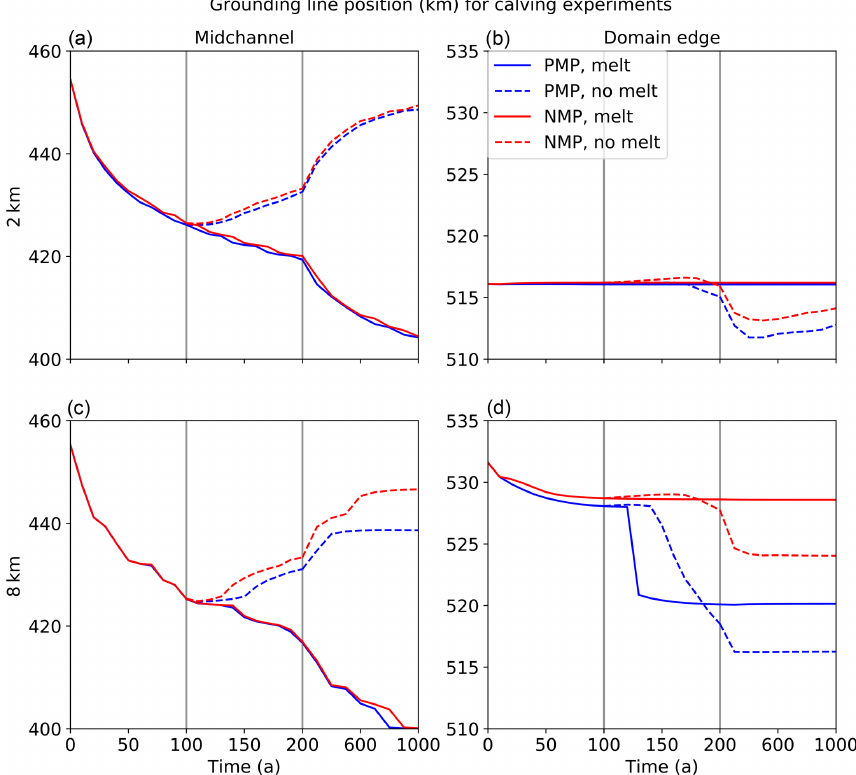
Figure 14. Evolution of the grounding line position (km) for calving experiments. We show two resolutions, 2km (a, b) and 8km (c, d) , for the midchannel (a, c) and the domain edge (b, d) and for the PMP (red) and NMP (blue) melt parameterizations. Solid lines denote continuous retreat (Ice2r–Ice2rr–Ice2rrx), and dashed lines denote recovery following the first 100 years of retreat (Ice2ra–Ice2rax). The time axis is scaled to focus on the first 200 years. Vertical lines are as in Fig. 11.